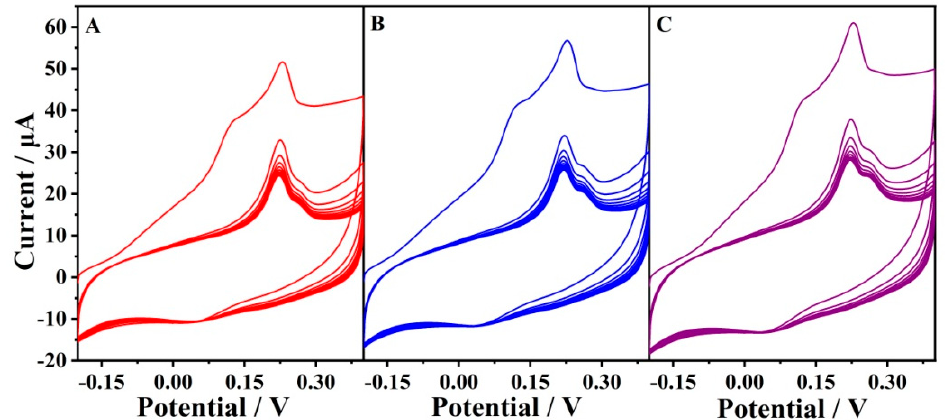
Figure 9. Reusable EGO 1/1.75V (cid:2876)(cid:2873)(cid:2906)(cid:2869) / (cid:2869) . (cid:2875)(cid:2873)(cid:2906) for the CV test of 5 mM GSH by a repeatable electrochemical oxi ‐ dation and reduction treatment. ( A ) The first treatment; ( B ) the second treatment; ( C ) the third treatment.